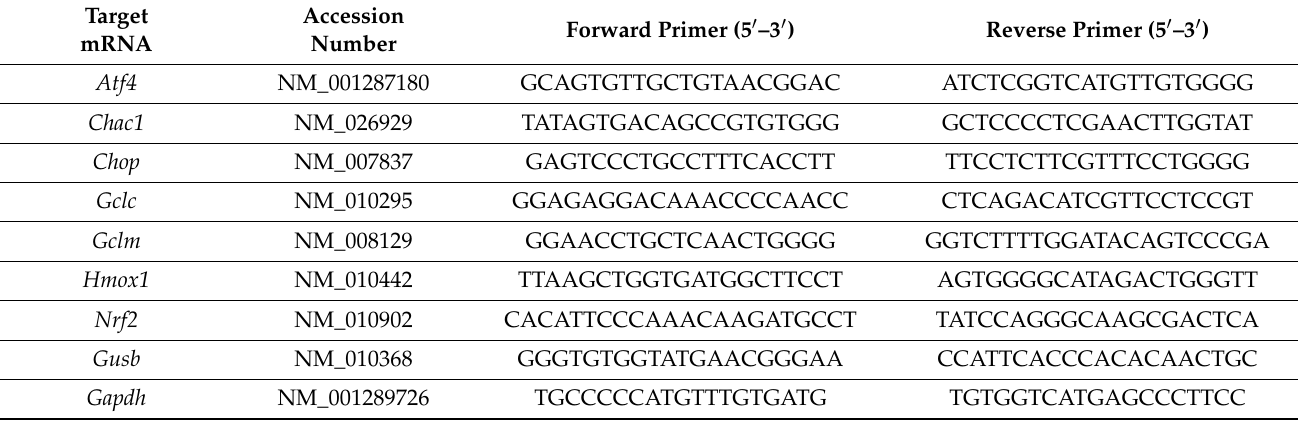
Table 1. Primers used for gene expression analysis in RAW 264.7